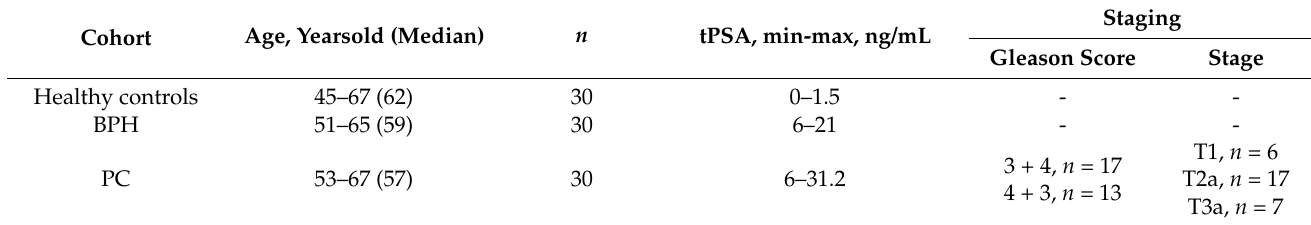
Table 1. Characteristics of selected